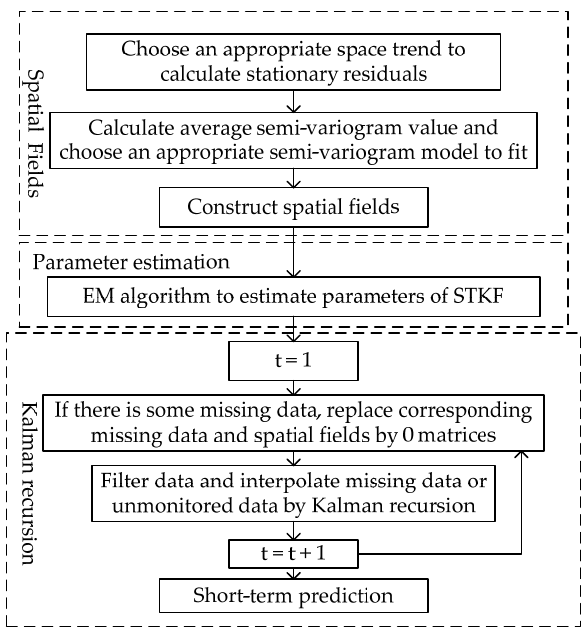
Figure 1. Flow diagram of the overall procedure of Space-Time Kalman Filter (STKF). EM algorithm, Expectation Maximization algorithm.